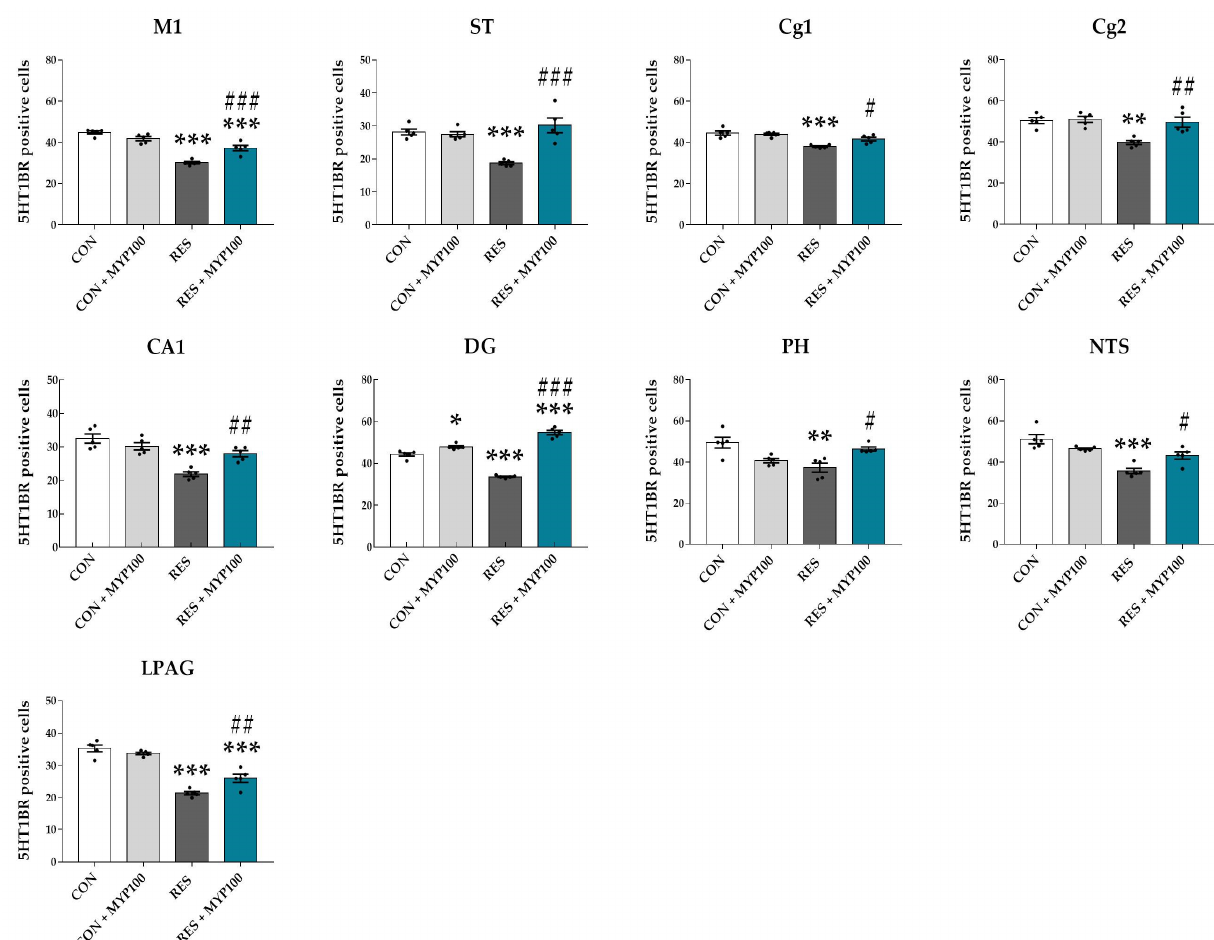
Figure 7. Changes in 5-HT1B receptor (5-HT1BR) expression in each brain region following myelophil (MYP) treatment. The number of 5-HT1BR-positive cells was significantly changed by MYP treatment in the motor cortex area 1 (M1), striatum (ST), cingulate area (Cg) 1, Cg2, cornu ammonis area 1 (CA1) and dentate gyrus (DG) of hippocampus, posterior hypothalamic area (PH), nucleus of solitary tract (NTS), and lateral periaqueductal gray (LPAG) regions. CON: control ( n = 5), CON + MYP100: 100 mg/kg MYP treatment ( n = 5), RES: 2 mg/kg of reserpine treatment ( n = 5), RES + MYP100: 2 mg/kg of reserpine followed by 100 mg/kg of MYP treatment ( n = 5). Data are expressed as means ± SEM. One-way ANOVA test with Tukey post hoc tests was executed. * p < 0.05, ** p < 0.01, *** p < 0.001 vs. CON; # p < 0.05, ## p < 0.01, ### p < 0.001 vs. RES.